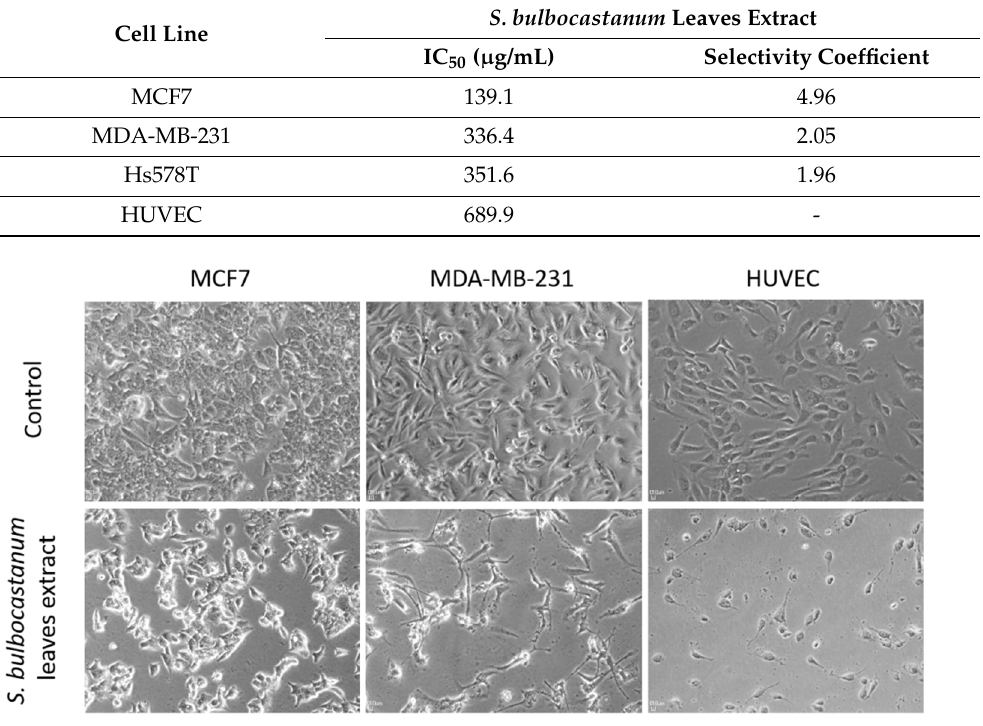
Figure 3. Morphological aspects of MCF7, MDA-MB-231 and HUVEC cells treated with the extract of S. bulbocastanum leaves, at a concentration equal to the IC 50 values, at 48 h after administration.